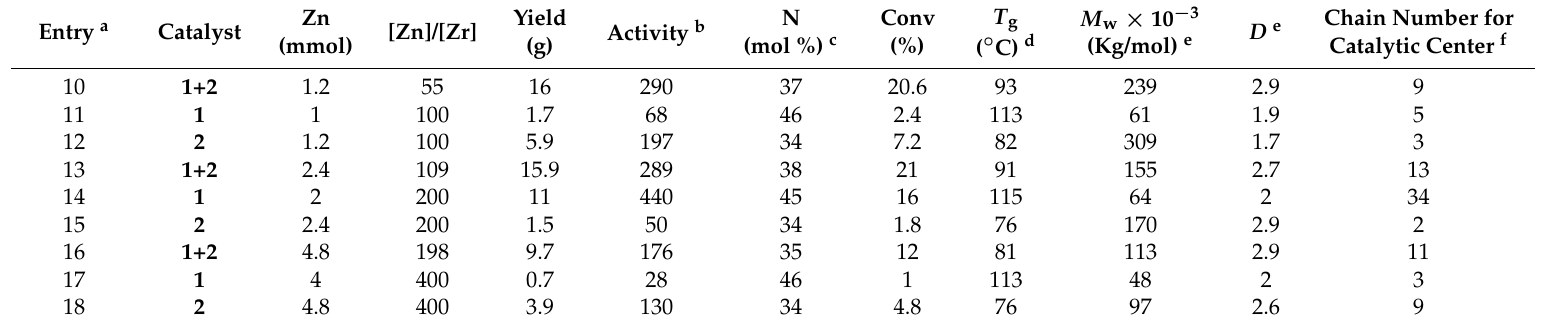
Table 2. Poly(Ethylene– co –Norbornene) using catalysts 1 and 2 in the presence of ZnEt 2 at [N]/[E] feed ratio of 4.8 and pE = 10